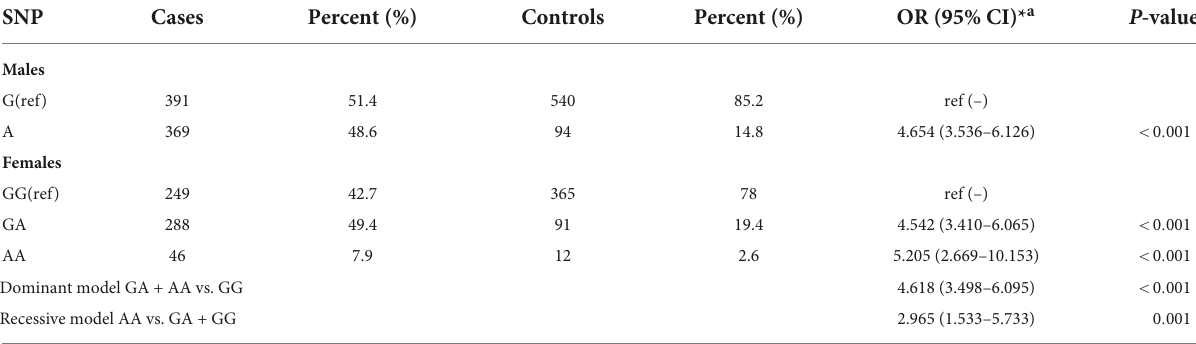
TABLE 3 Allele and genotype frequencies of rs17276588 polymorphism among ischemic stroke (IS) cases and controls their impact on the risk of developing ischemic stroke